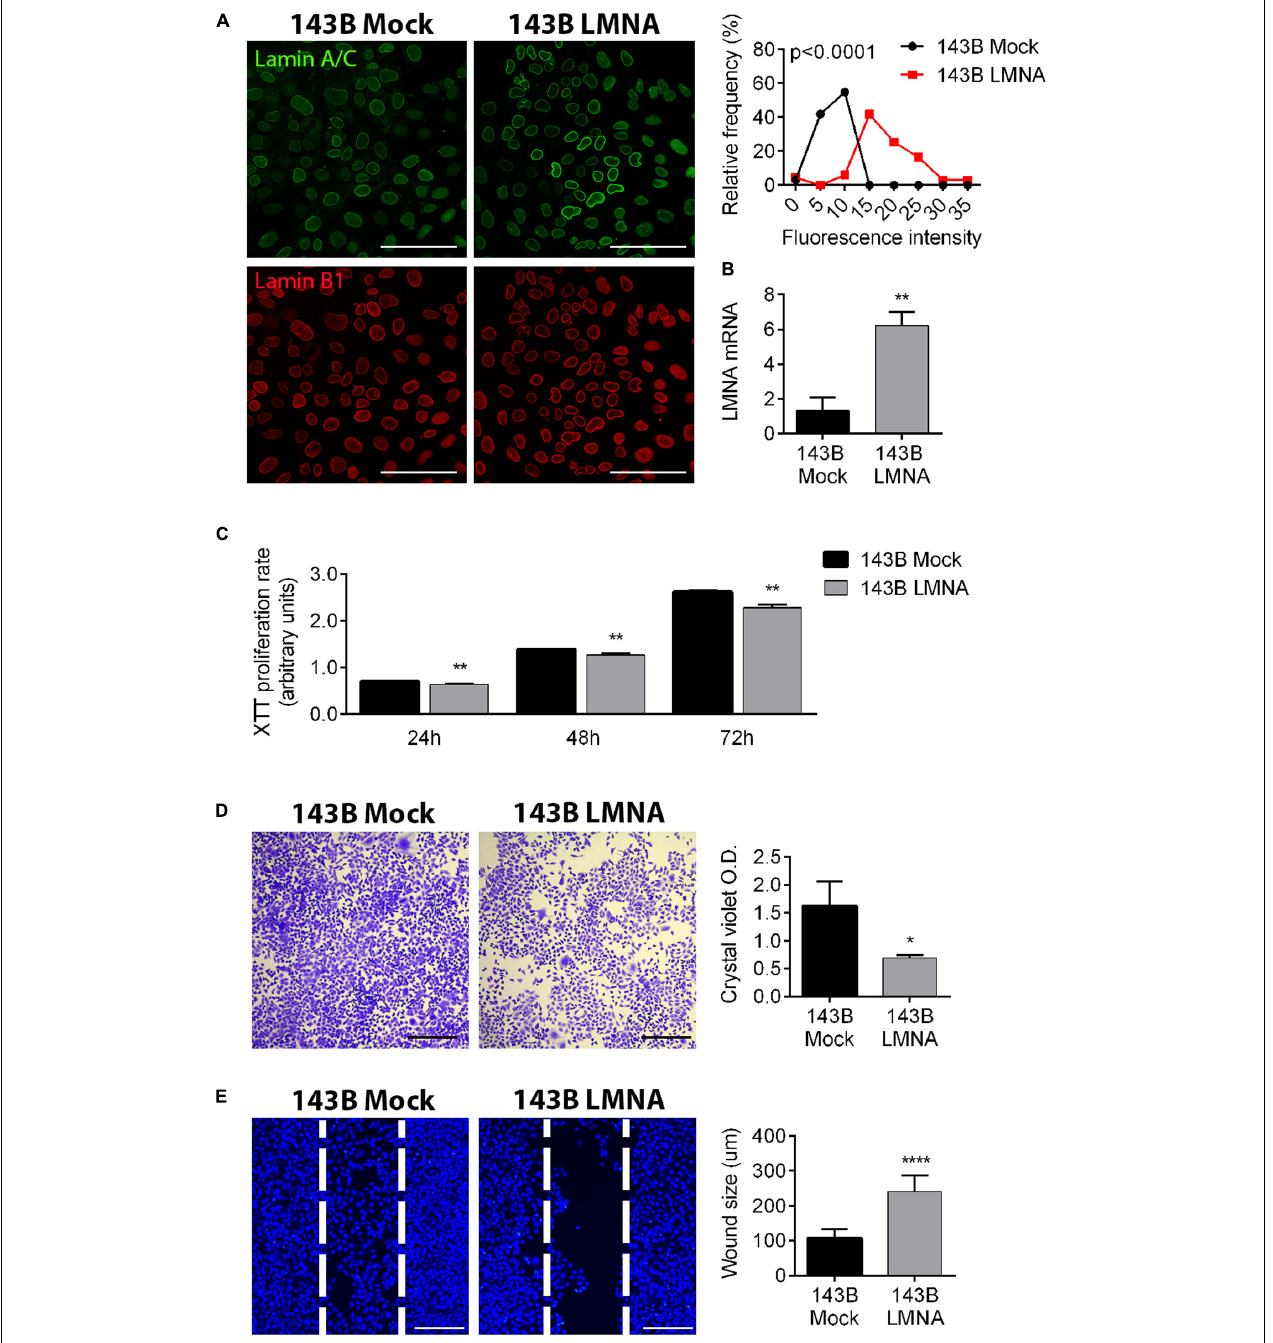
FIGURE 2 | Modulation of Lamin A/C expression in 143B cells alters tumor phenotype. (A) Confocalmicroscope imaging of Lamin A/C (pseudo-colored in green) and Lamin B1 (red) in mock-transfected (143B mock) and Lamin A/C-transfected (143B LMNA) 143B cells. Assessment of the relative frequencies of immunofluorescence intensities of Lamin A/C in 143B Mock (black line) and 143B LMNA (red line) cells. Bar: 100 µ m, n = 100. (B) mRNA expression of LMNA gene in mock-transfected (143B mock) and Lamin A/C-transfected (143B LMNA) 143B cells, normalized versus GAPDH gene expression. ** p < 0.01. (C) XTT proliferation assay performed at 24, 48, and 72 h on mock-transfected (143B mock) and Lamin A/C-transfected (143B LMNA) 143B cells. ** p < 0.01. (D) Representative pictures of crystal violet staining of 143B Mock and 143B LMNA cells (left panels) and the relative quantification (right panels) as an evaluation of cell proliferation at 72 h after plating. Bar: 500 µ m. * p < 0.05. (E) Representative pictures of the wound healing assay performed on 143B Mock and 143B LMN-A cells stained with the nuclear dye Hoechst and assessed at 24 h after Ibidi insert removal (left panels). The white dashed line represents the position of cell migrating front at Ibidi insert removal ( T = 0). Bar: 200 µ m. **** p < 0.001.